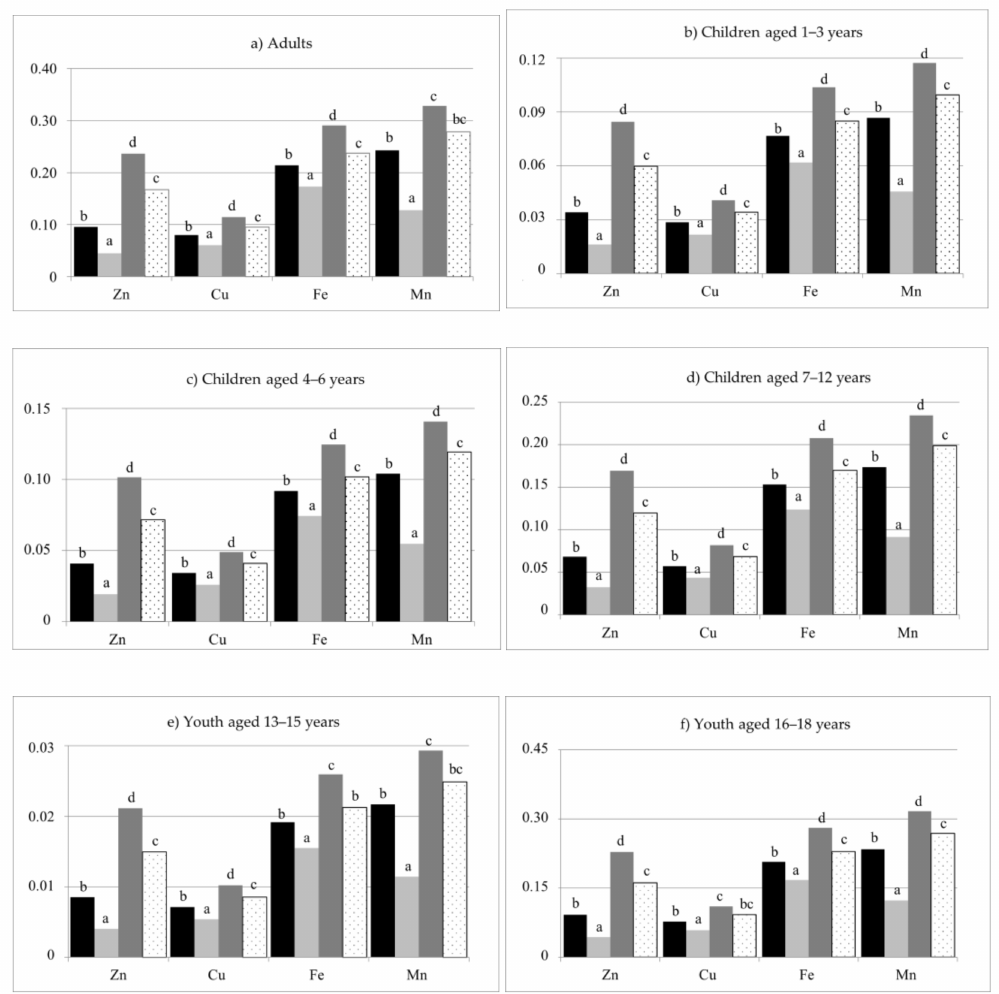
Figure 4. Intake of Zn, Cu, Fe, and Mn with analysed pasta per portion, cooked, mg. Portion size: ( a ) Adults 140 g [24], ( b )